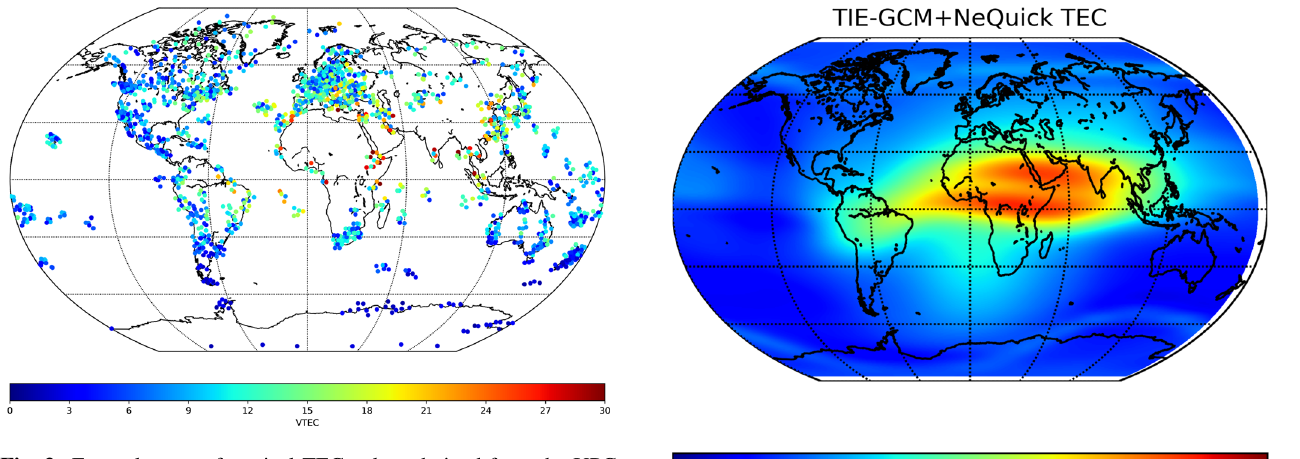
Fig. 3. Example map of vertical TEC values derived from the UPC dataset of slant TEC (which is assimilated) on June 5th 2017 at 1230 UT. The colour bar shows the VTEC value (in TECU).